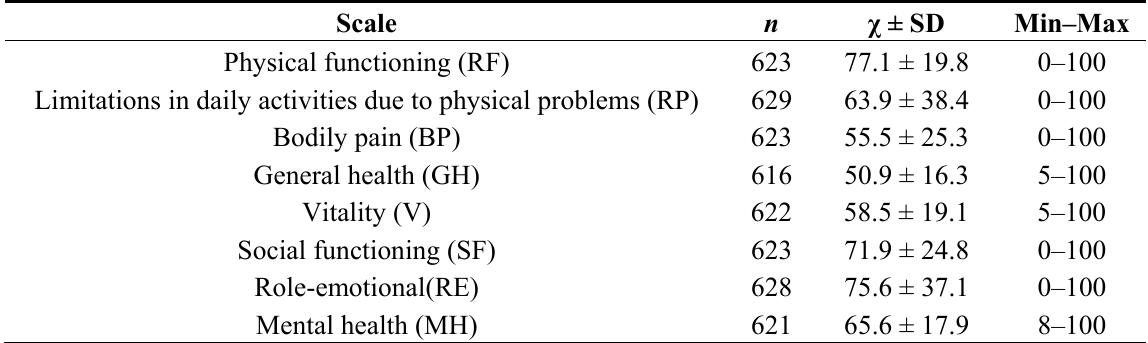
Table 2. Quality of life of respondents according to the SF-36.